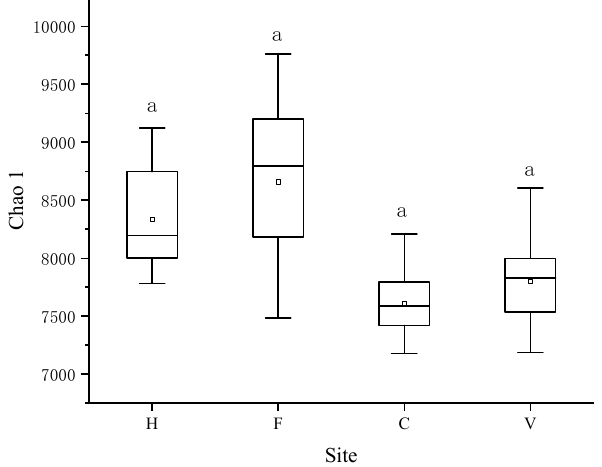
Figure 6. Rarefied Chao 1 index. H: hospital; F: farm; C: city residence; V: village residence. Error bars indicate standard errors of three replicates, different lowercase letters indicate a significant difference ( p < 0.05).